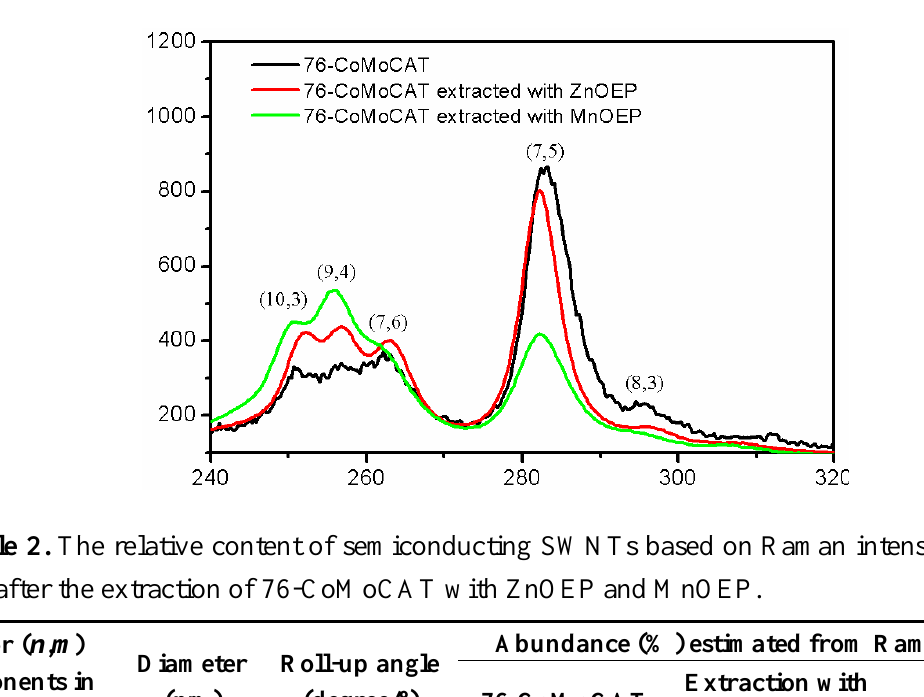
Figure 6. Raman spectra of 76-CoMoCAT before and after extraction with ZnOEP and MnOEP at an excitation wavelength of 633 nm. The Raman spectra were normalized to the G-band intensity.